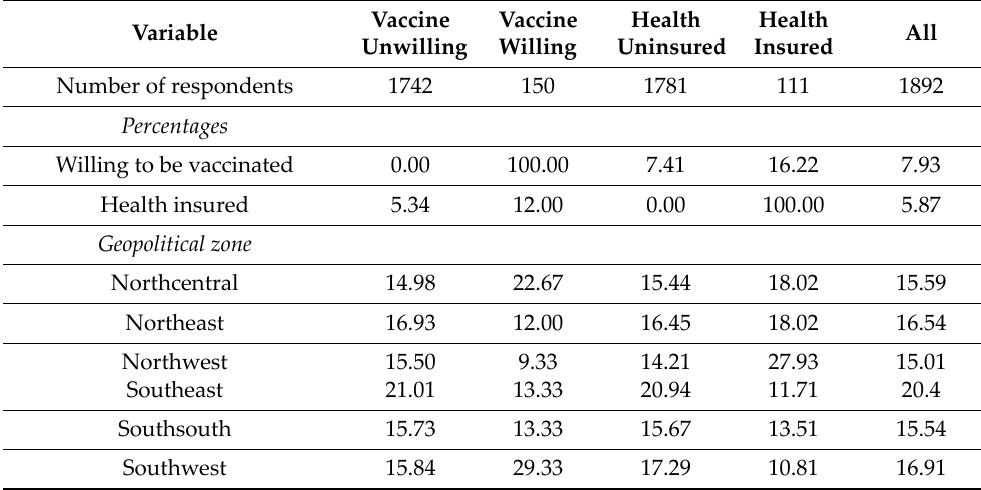
Table 2. Percentages and means of respondents’ demographic variables across vaccine hesitancy and health insurance status.